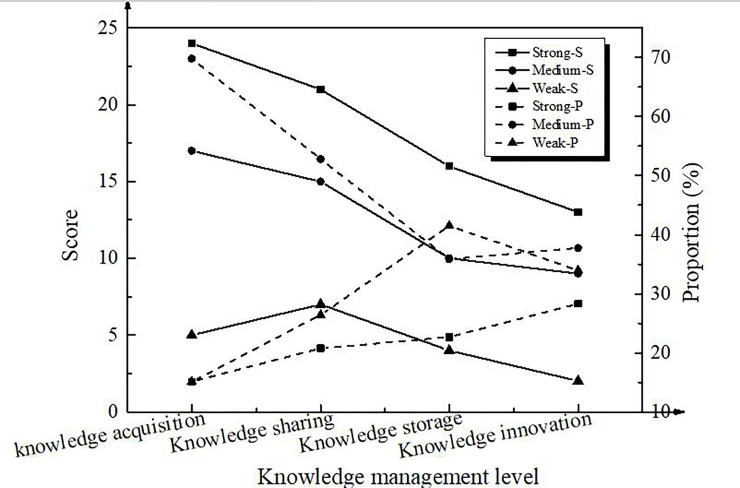
Statistical results of knowledge management level.